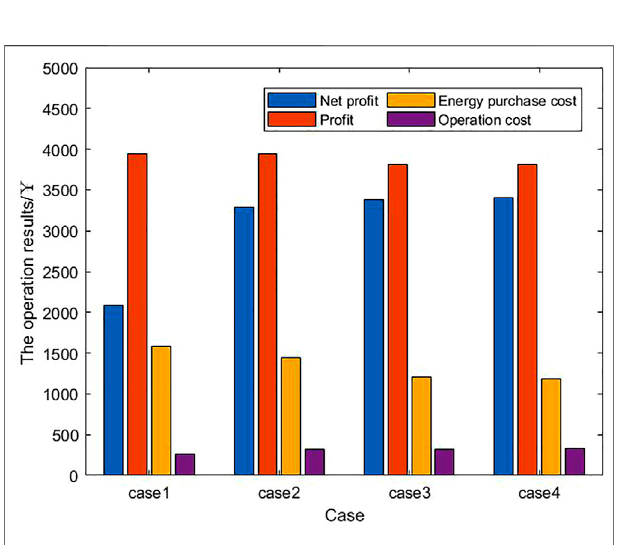
FIGURE 2 | The load curves (left) and the wind turbine and photovoltaic output curves (right).